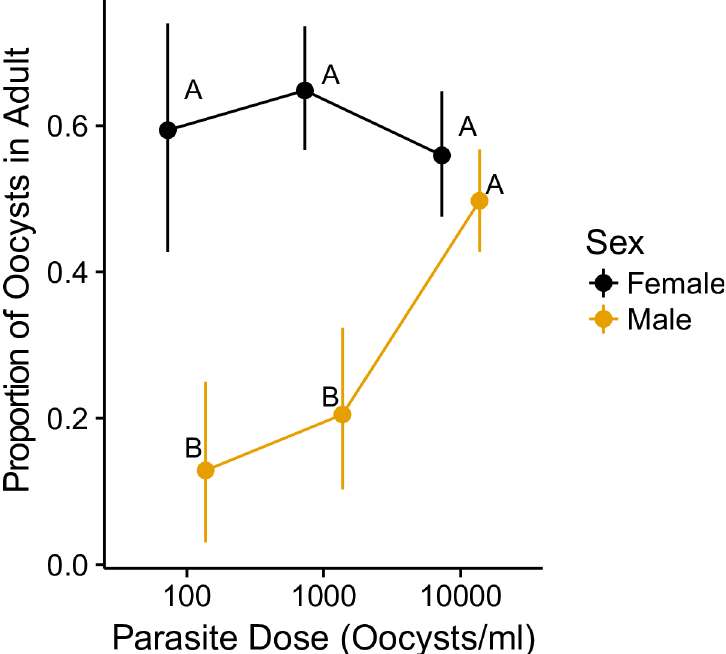
Fig 5. The percent of oocysts in the adult mosquito at three parasite dosages. Male mosquitoeshad a smaller proportionof oocysts in the adult until the highestdosage, 10000oocysts/ml, where male and female mosquitoeshad the same percent of oocysts in adults. Different letters correspond to separate Tukey’s HSD tests on the ANCOVA model. Whiskers are bootstrapped 95% confidenceintervals(1000 replicates). Mean points are dodgedfor visibility.